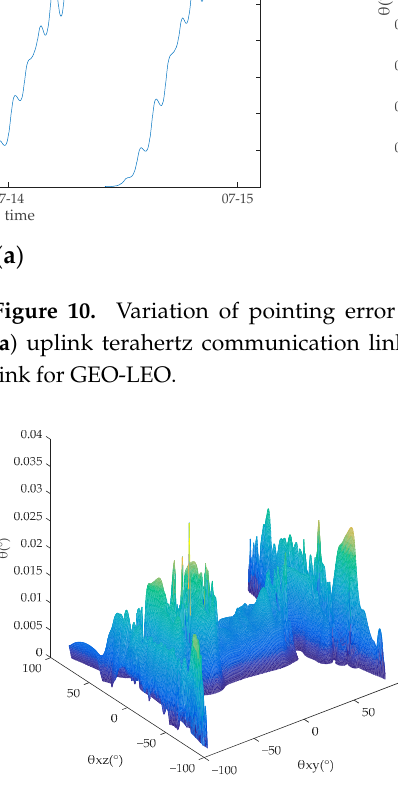
Figure 11. Relationship between transmitter pitch angle, azimuth angle and pointing error angle.